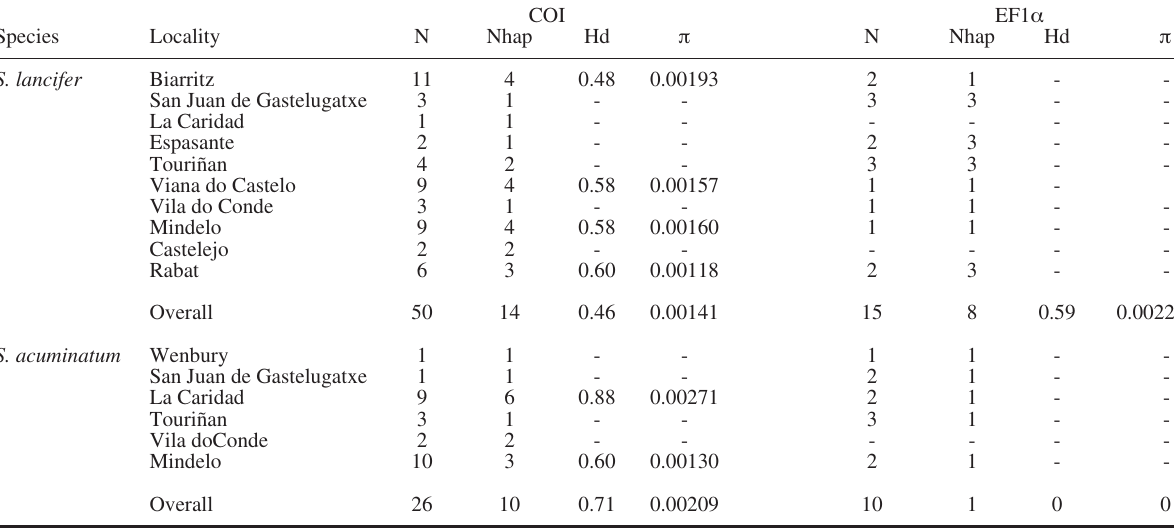
Table 1. – Estimates of genetic diversity parameters for COI and EF1 α sequence data of S. lancifer and S. acuminatum. N, number of indi- viduals; Nhap, number of haplotypes; Hd, haplotype diversity; π , nucleotide